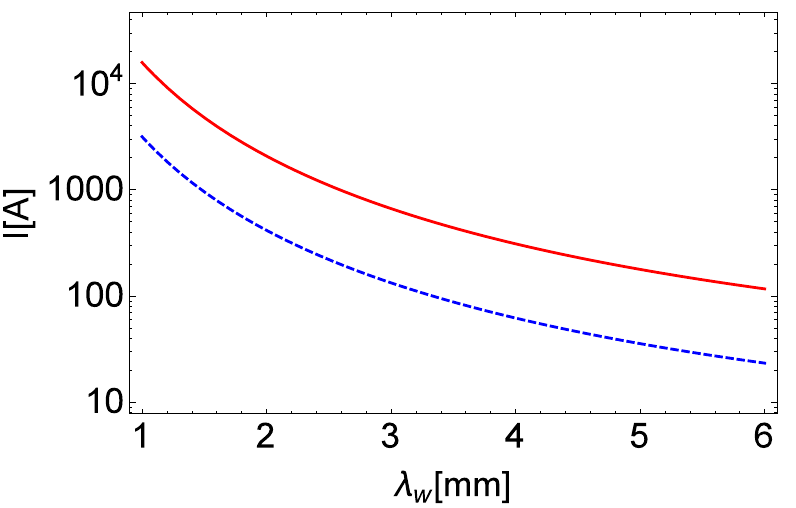
Figure 5. Electron beam current vs. the undulator wavelength for λ r ≡ 1 nm (continuous line) and λ r ≡ 5 nm (dashed line); derived from Equation (5) using the parameters values reported in Figure 4 and assuming σ x = σ y